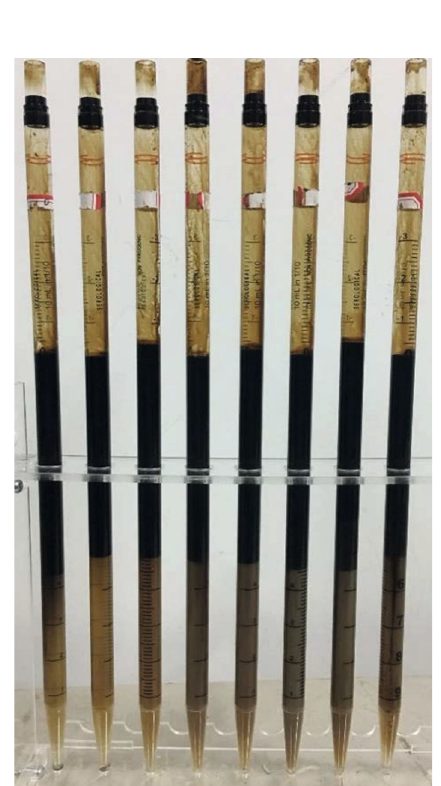
Figure 1: Phase behavior of surfactant and crude oil. The salinity from left to right is 0, 0.25%, 0.5%, 0.75%, 1%, 2%, 3%, and